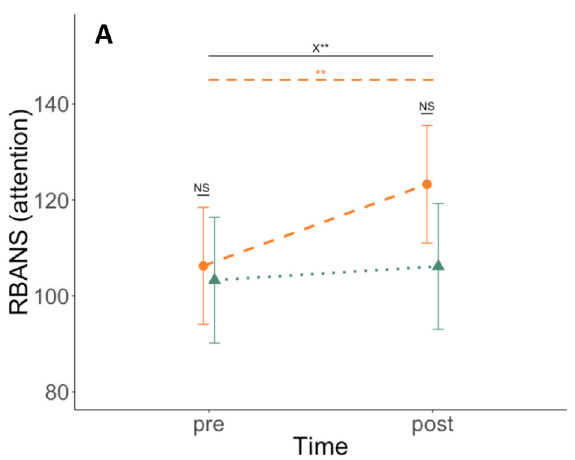
Figure 5. Mean pre- and postscores on the Repeatable Battery for the Assessment of Neuropsychological Status (RBANS) Attention index for the sham (dotted, triangles) and real (dashed, circles) group with 95% confidence intervals. Continuous lines with X indicate interaction effects, dashed and dotted lines indicate a significant difference between the pre- and postscores of the separate group (real: dashed; sham: dotted) as found by the post-hoc analyses. X = interaction effect; NS = non-significant; * = p ≤ 0.05; ** = p ≤